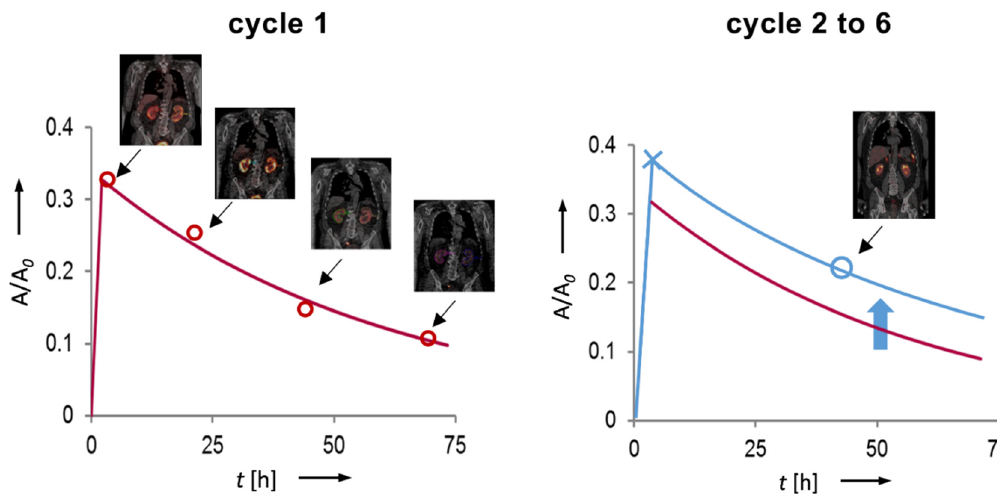
Figure 1. Principle of the scaling of the time-activity curve of cycle one based on a single time point measurement in the following cycles (in this example approx. 48 h p.i.). The TAC is corrected for cycle-specific differences in organ uptake, while maintaining the kinetic behavior derived in cycle one.